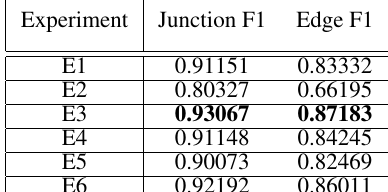
Table 2. Precision and recall of experiments with different loss factor setups, see Table 1. Cases E3 and E6 performed best, where we used a higher factor λ junc in the training phases.